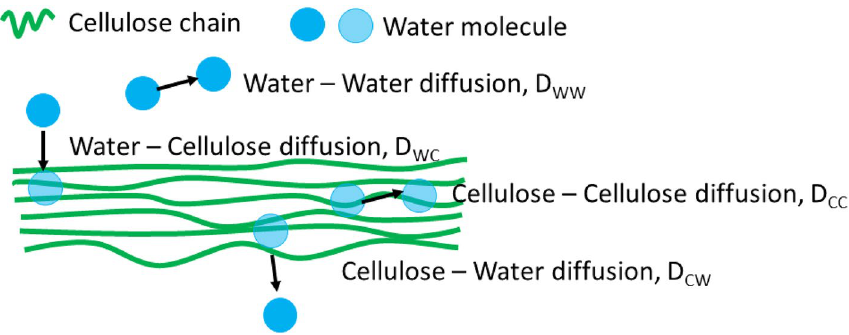
Figure 6. The different phases for analyzing the diffusion of water